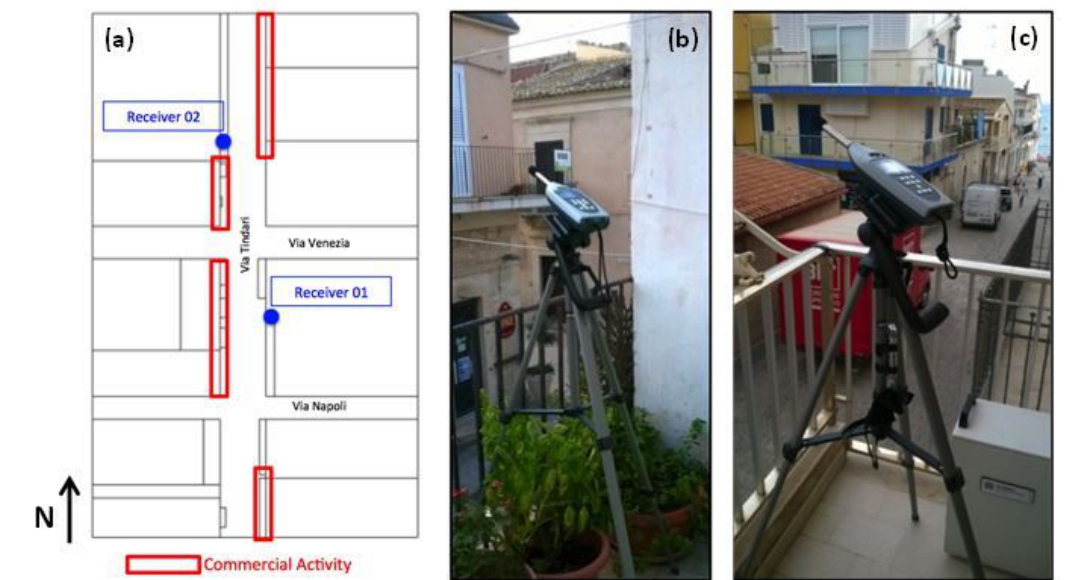
Figure 7: (a) Positions for the noise measurement sessions; (b) Receiver 01; (c) Receiver